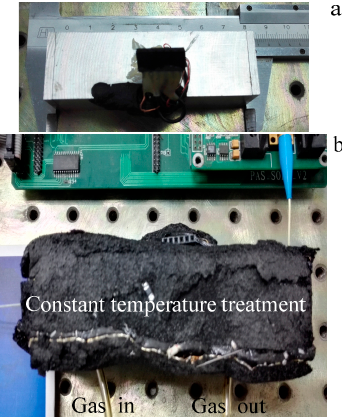
Figure 3. ( a ) The PA cell and ( b ) the constant temperature treatment device.